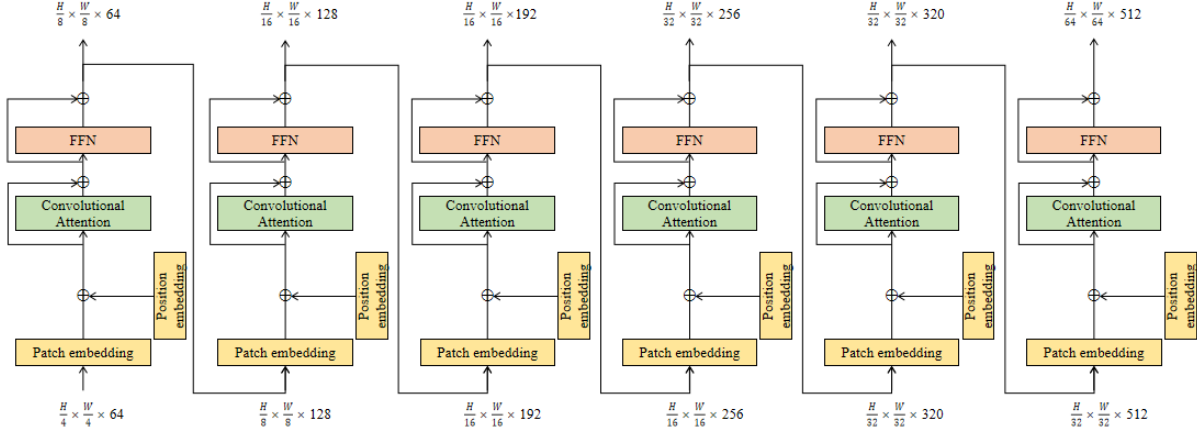
Figure 3. Multilevel field transformer structure.